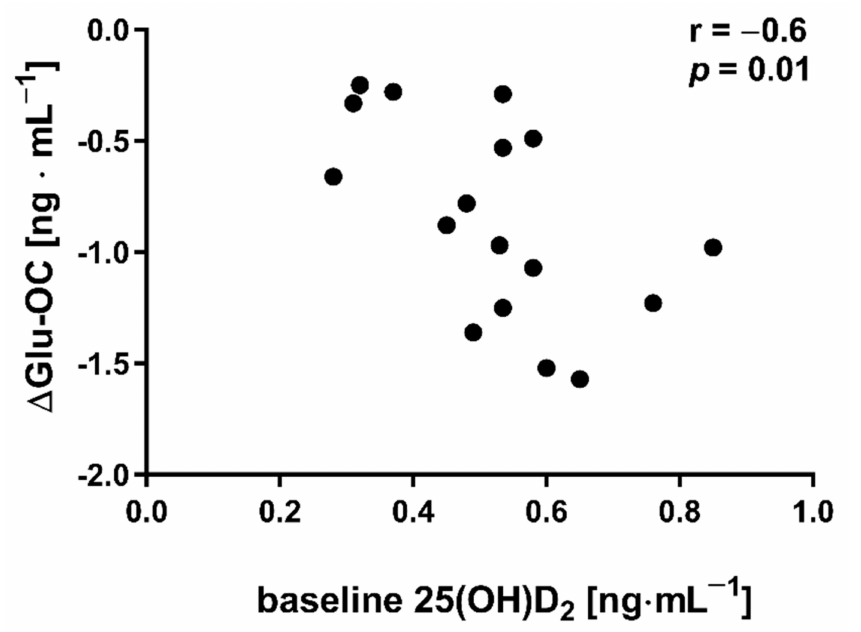
Figure 4. Correlation between baseline concentration of 25(OH)D 2 and delta changes ( ∆ POST to PRE) in undercarboxylated osteocalcin (Glu-OC) among participants from NW